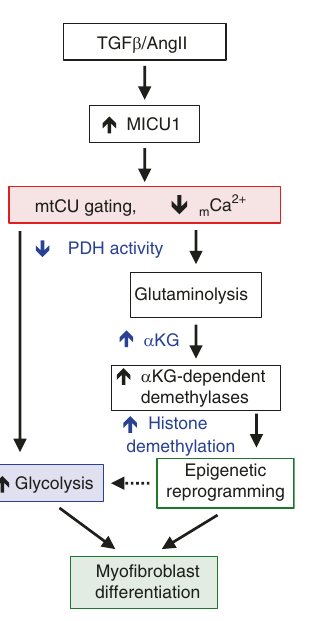
Fig. 7 Enhanced mtCU gating is essential for myo fi broblast